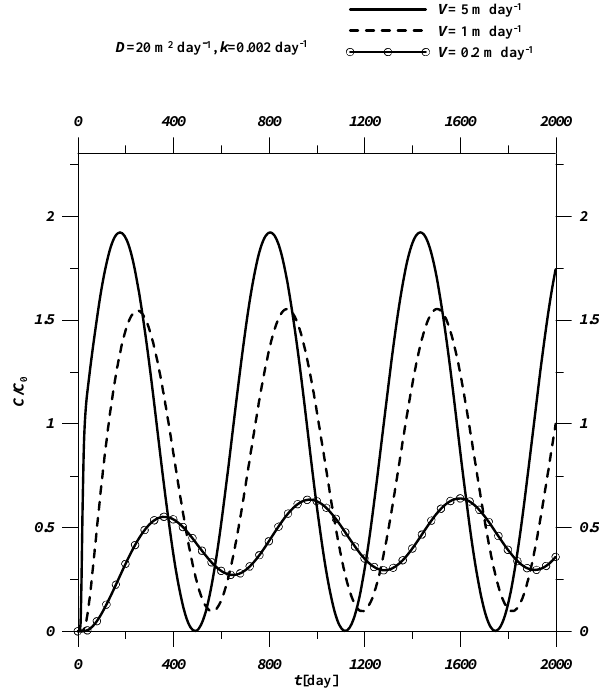
Fig. 4 Fig. 4. Comparison of the breakthrough curves at x = 100m for different V . The sinusoidally periodic input function is f (t) = 1 + sin t . Parameter V is varied and other parameters are kept constant.